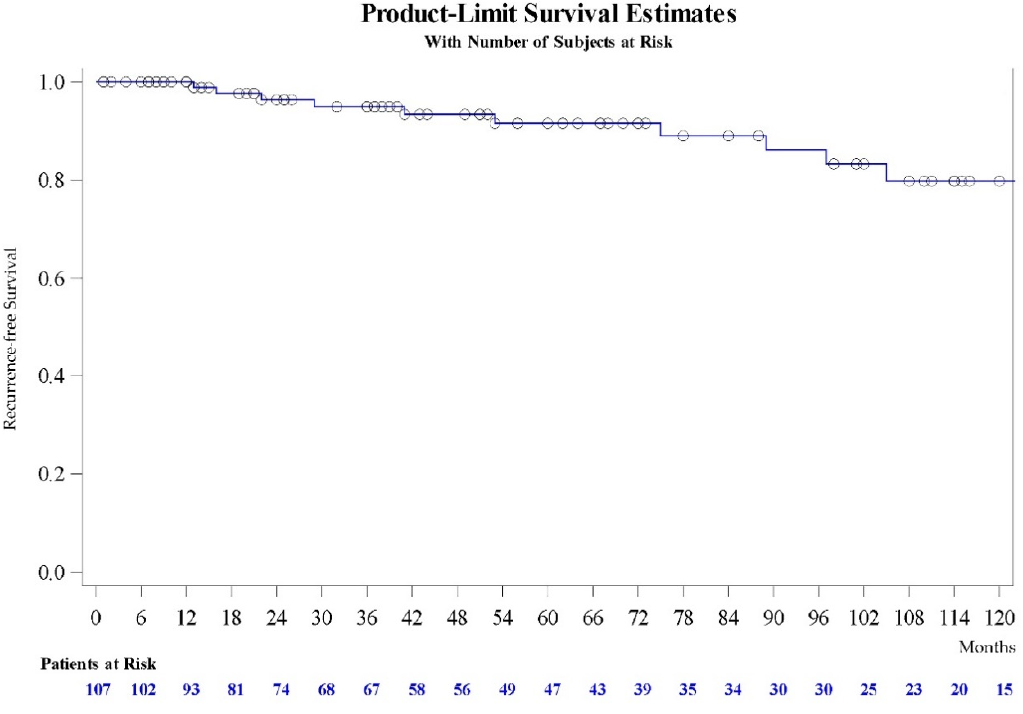
Figure 1. Kaplan–Meier curve of recurrence free survival of urethral stenosis after bulbomembranous dorsal onlay buccal mucosa graft urethroplasty (DOBMGU). Table 2. Association between stenosis recurrence and clinical features. Variables with statistical significance ( p < 0.05) are highlighted in bold; variables with p < 0.1 were considered for the stepwise model regression analysis (*). 1 HT/CVD, hypertension and/or cardiovascular disease; 2 TURP, transurethral resection of the prostate; 3 DVIU, direct vision internal urethrotomy; 4 According to Clavien–Dindo classification within 90 postoperative days.